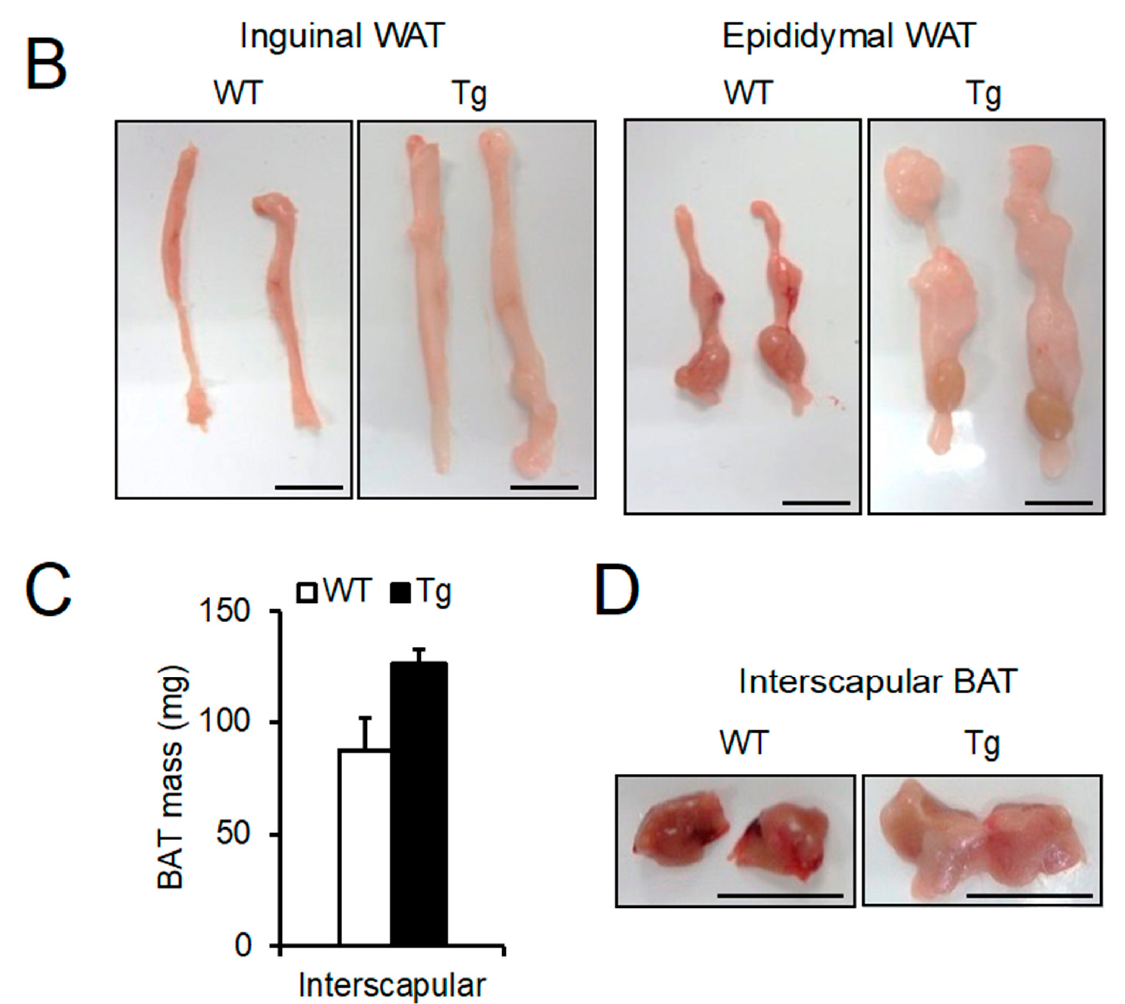
Figure 3. Phenotypic analysis of adipose tissues of the 13-line of Npgl Tg mice. ( A ) The masses of inguinal, epididymal, retroperitoneal, and perirenal WAT. ( B ) Representative photographs of inguinal and epididymal WAT. ( C ) The mass of interscapular BAT. ( D ) Representative photographs of interscapular BAT. Scale bars = 1 cm. All statistical analyses were performed using Mann–Whitney U test. Each value represents the mean ± SEM ( n = 5–8). Asterisks indicate statistically significant differences (* p < 0.05, ** p < 0.01). Npgl , neurosecretory protein GL; WT, wild-type; Tg, transgenic; WAT, white adipose tissue; BAT, brown adipose tissue.